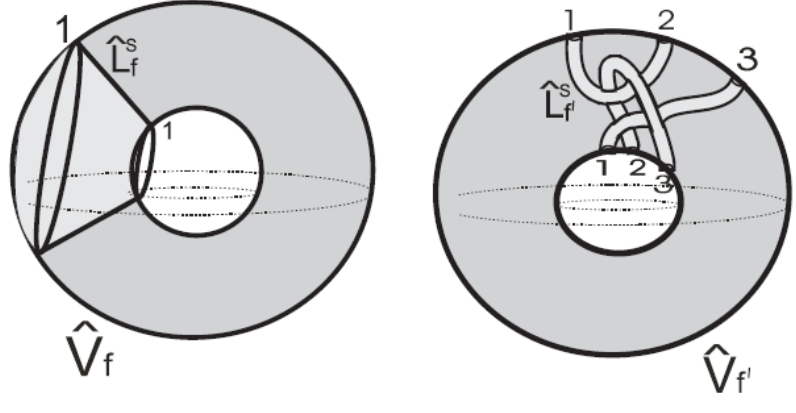
Fig. 3 The complete invariants for trivial and non-trivial Pixton’s